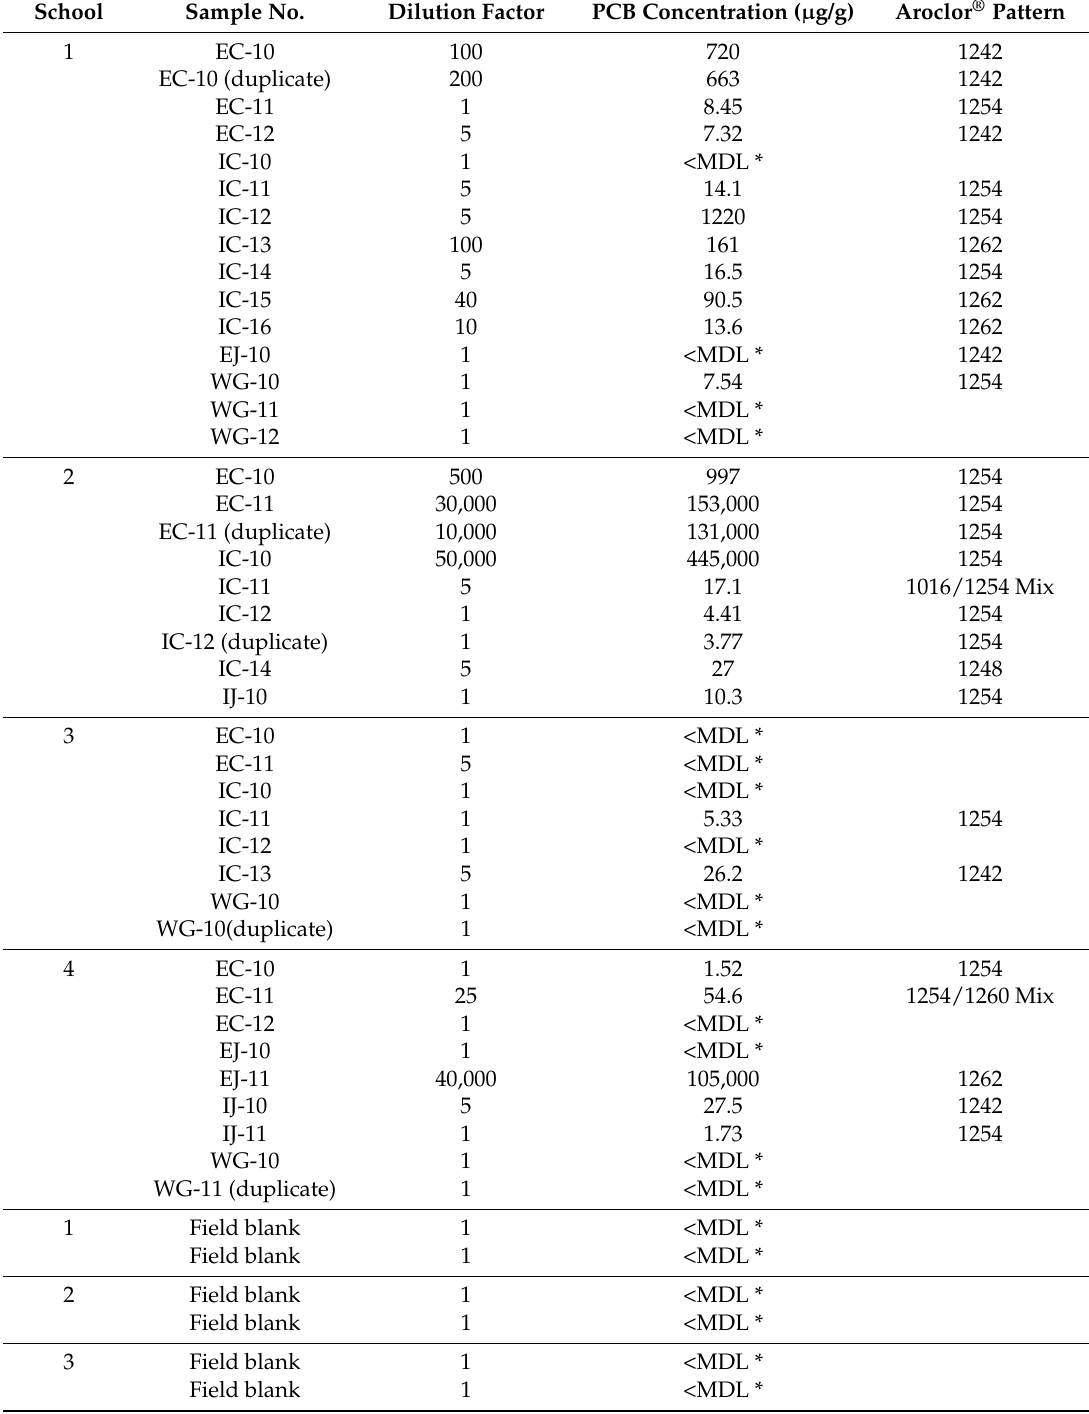
Table 5. Sample Number, Dilution Factor, PCB Concentration, and Aroclor ® Pattern